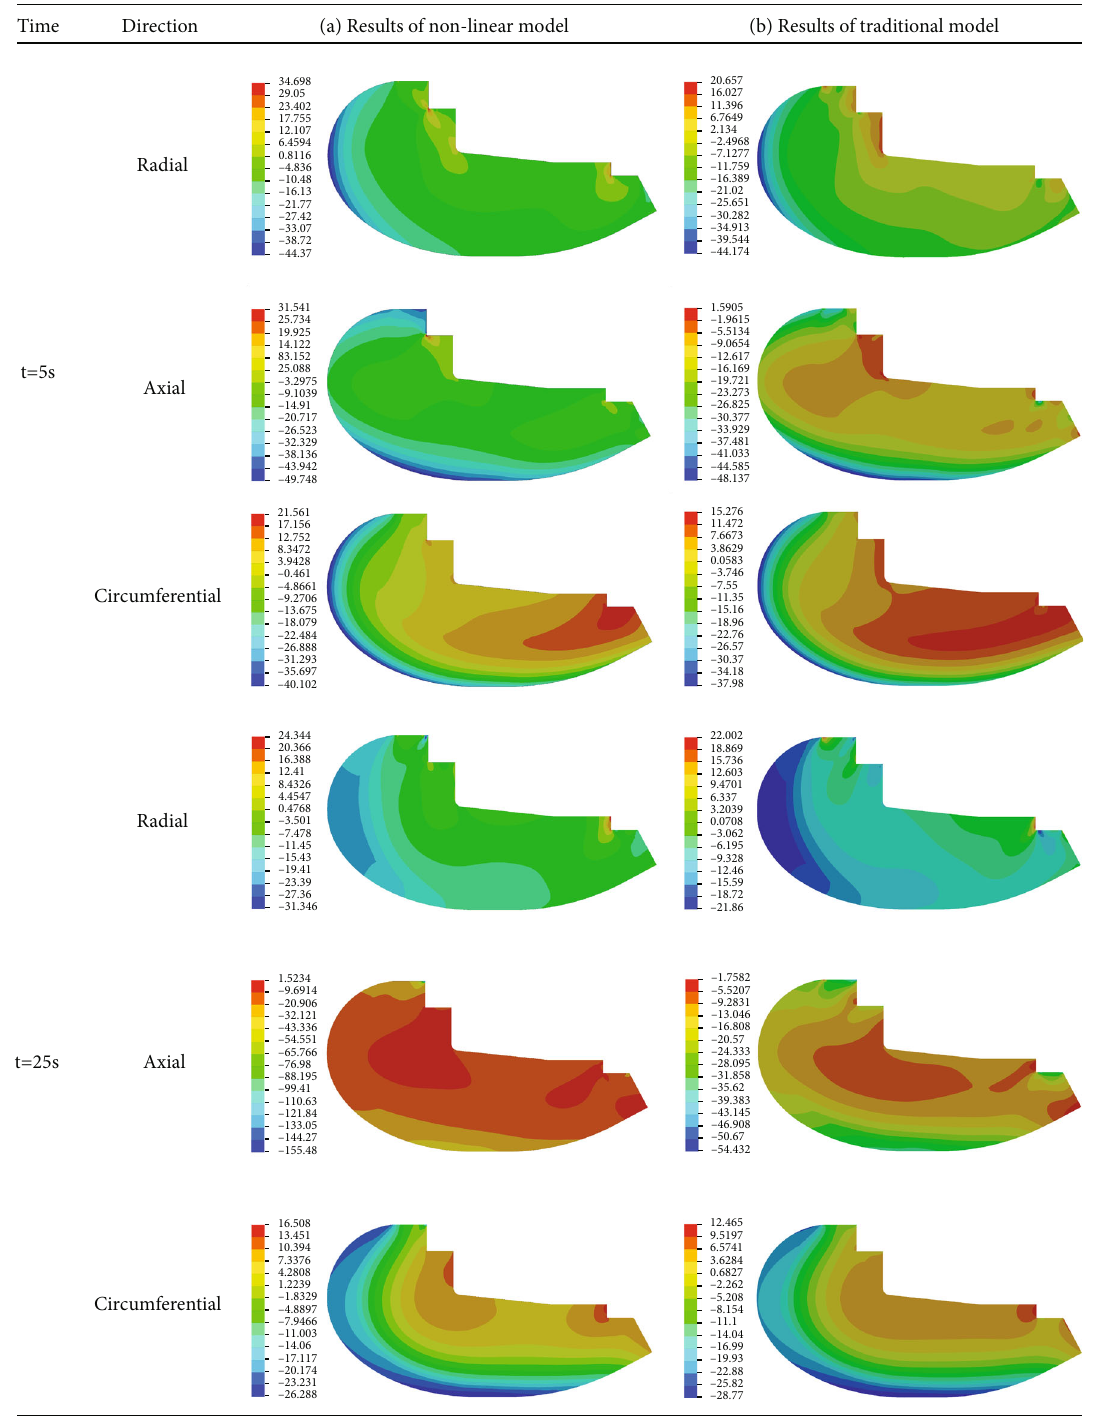
Figure 14: Graphs of Von Mises stress distribution of nozzle insert (MPa). Table 6: Actual stress range and permissible stress range of nozzle insert